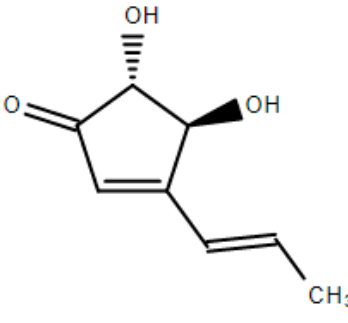
Figure 1. Chemical structure of terrein.